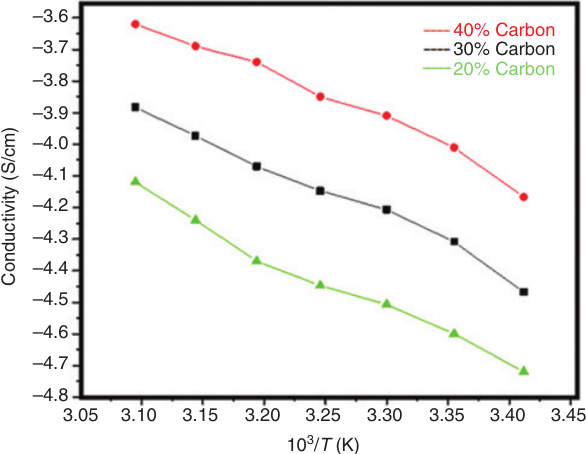
Figure 3: Variation of log conductivity of carbon-doped potash alum (20%, 30%, and 40%) with